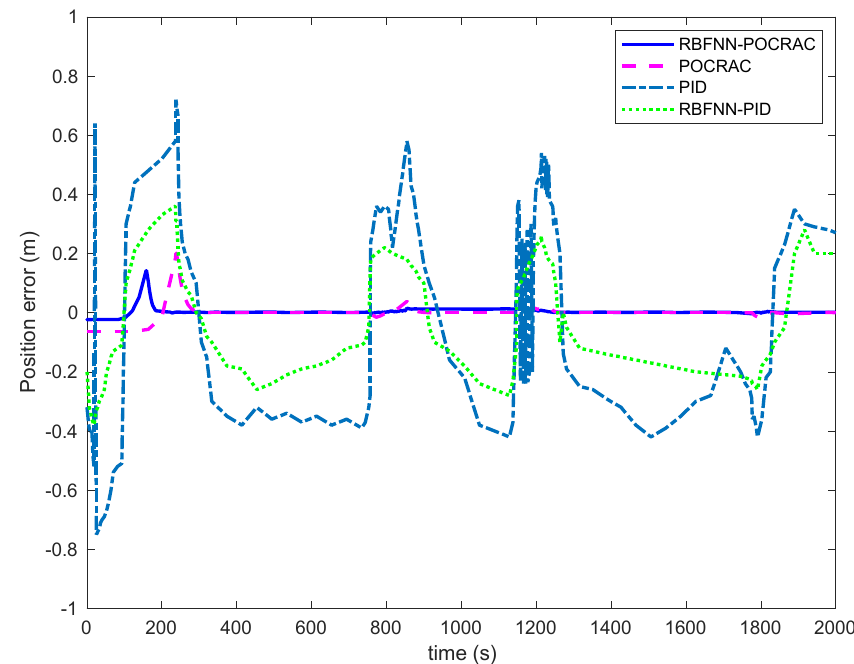
Figure 9. Position error comparison.